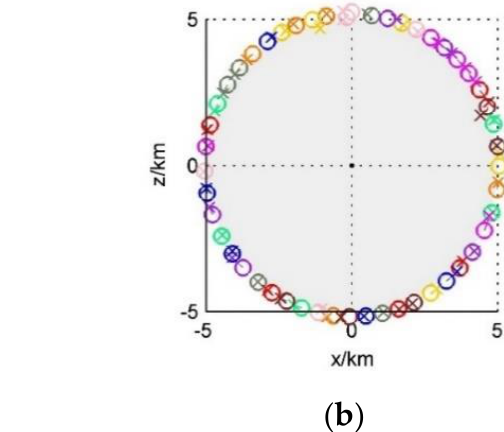
Figure 15. The in-plane circle formation ( 0.5km, 20km r = = − ). ( a ) Relative motion trajectory in 0- 500 s; ( b ) Relative motion trajectory in 500 – 2000 s.